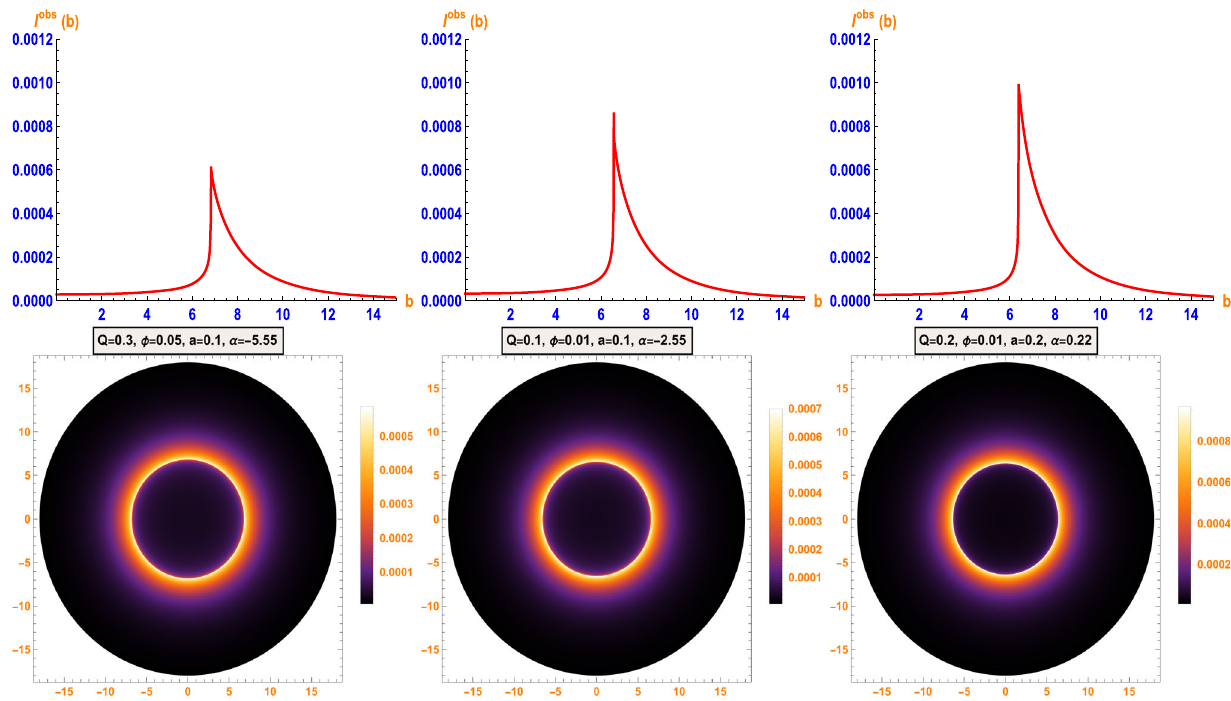
Fig. 9 The graphical interpretation of the total observed intensity I obs (cid:20) ( b ) reflects with an infalling spherical accretion flow matter, for different BH state parameters and the mass of BH as M = 1. We choose these numerical values as three examples, and one can find a comprehensive details in the main